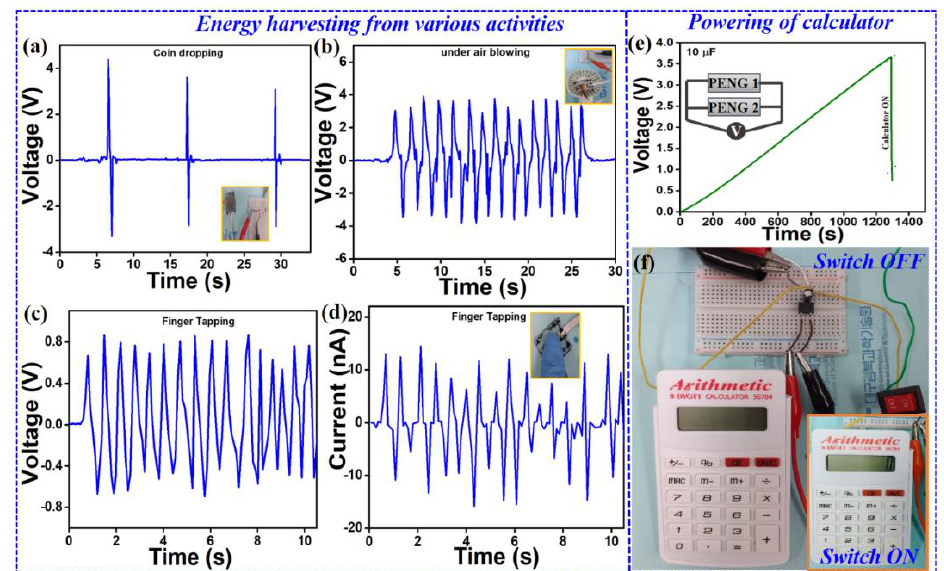
Figure 5. Applications of harvesting energy and powering electronics. ( a ) Electrical response of PNG10 when a coin drop upon it, ( b ) Electrical response of the PNG-10 device when connected to fan; ( c , d ) Voltage and current response of PNG10 device upon finger tapping, ( e ) connected two PNG10 devices in parallel and charge a 10 µF capacitor, and ( f ) Power supply to low power rating devices like calculator (switch OFF and switch ON condition).